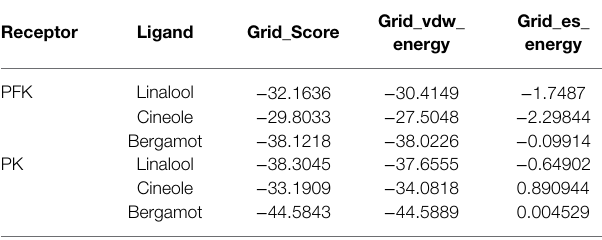
TABLE 3 | Binding affinity results from molecular docking